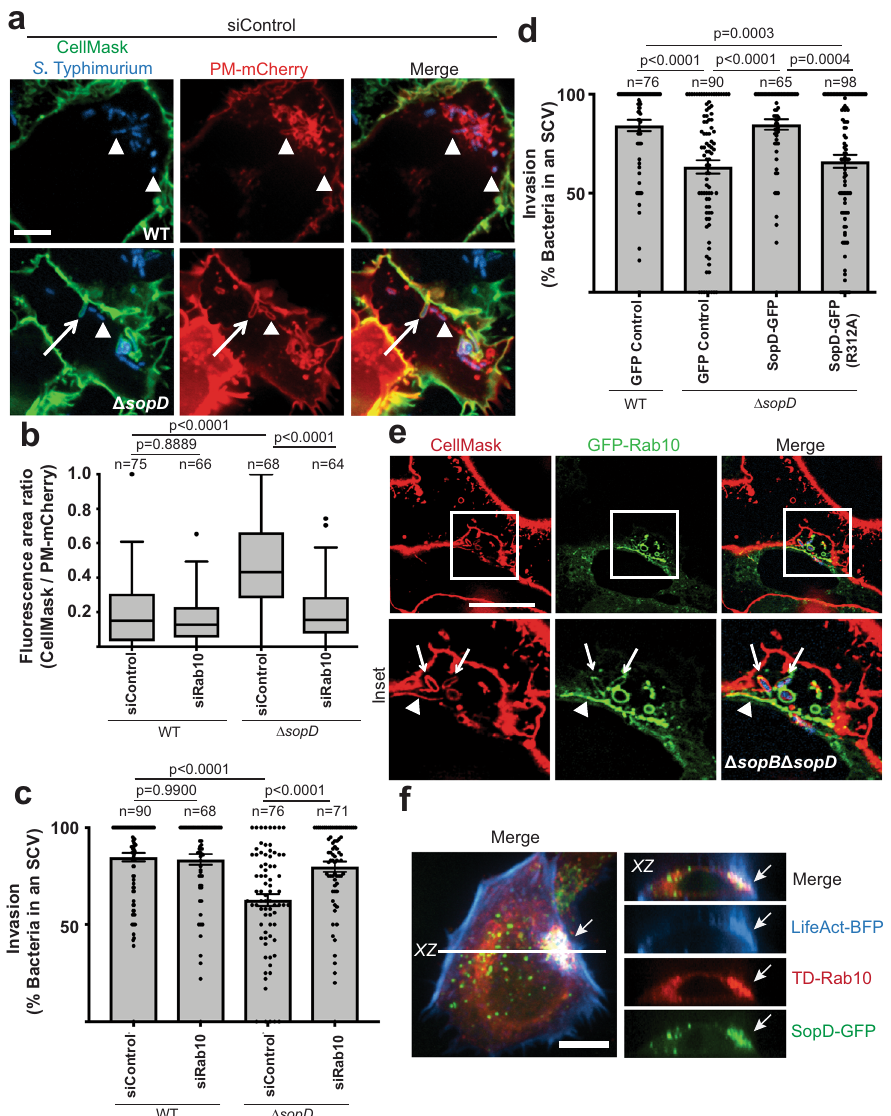
Fig. 3 SopD inhibits Rab10 to promote plasma membrane scission during S . Typhimurium invasion. Henle 407 cells were transfected with the indicated siRNA and then PM-mCherry 24h later. a Representative images of cells that were then infected with BFP expressing WT or Δ sopD mutant Salmonella for 20min and labelled with CellMask (green). Arrow indicates a PM-mCherry positive Salmonella -containing compartment that is accessible to CellMask. Arrowhead indicates a sealed Salmonella -containing vacuole that is inaccessible to CellMask. Scale bar, 7 μ m. Data are representative of three independent experiments. b The extent of membrane scission in cells transfected with Control siRNA or Rab10 siRNA #1 (see methods), followed by transfection with the indicated GFP construct and PM-mCherry 16-18h prior to infection with WT or Δ sopD mutant Salmonella . The fl uorescence area labelled with CellMask (at 20min post-infection) compared to that labelled with PM-mCherry is used as an index of sealing at the invasion site. Data are visualized with Tukey-style boxplots, where the boxes represent the 25th, 50th/median and 75th percentiles. The whiskers denote 1.5× the IQR (interquartile range) from the median. Points denote outliers beyond 1.5× IQR. Statistical analysis was performed with one-way ANOVA. P -values and the number of independent cells used for measurements ( n ) are indicated in the fi gure. c Invasion represented as the percent of bacteria in Salmonella -containing vacuoles. The total number of bacteria that were positive for PM-mCherry at the invasion site was quanti fi ed and the proportion of these bacteria that were negative for CellMask was determined. These bacteria were in a sealed compartment that was considered an SCV and the number was used to represent the invasion ef fi ciency. Data are means±S.E.M. Statistical analysis was performed with one-way ANOVA. P -values and the number of independent cells used for measurements ( n ) are indicated in the fi gure. d Henle 407 cells were transfected with the indicated GFP construct and PM-mCherry 16 – 18h prior to infection with WT and Δ sopD mutant Salmonella . Invasion represented as the percent of bacteria in Salmonella -containing vacuoles (as described for (c)). Data are means±S.E.M. Statistical analysis was performed with one-way ANOVA. P -values and the number of independent cells used for measurements ( n ) are indicated in the fi gure. e Henle 407 cells were transfected with GFP-Rab10 and then infected with a Δ sopB Δ sopD mutant strain of Salmonella for 20min and labelled with CellMask (red). Scale Bar, 21 μ m. GFP-Rab10 colocalizes with CellMask positive Salmonella - containing compartments (indicated with arrows) and CellMask positive tubules (arrowhead). Data are representative of three independent experiments. f Representative z-slice image of Henle 407 cells that were transfected with TD-Rab10, SopD-GFP and LifeAct-BFP, then infected with WT S . Typhimurium SL1344. Cells were imaged live at 10min post-infection and actin-enriched ruf fl ing was used to identify the invasion site. Arrow indicates site of invasion and line indicates location of slice on merged image. Scale Bar, 10 μ m. Data are representative of three independent experiments. SCV Salmonella -containing vacuole, WT wild type, BFP blue fl uorescent protein, GFP green fl uorescent protein, TD TdTomato. Source data are included in source data fi